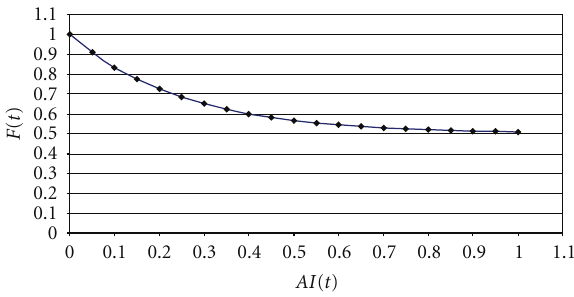
Figure 1: Scaling factor ( F ) versus a ffi nity index (AI( t